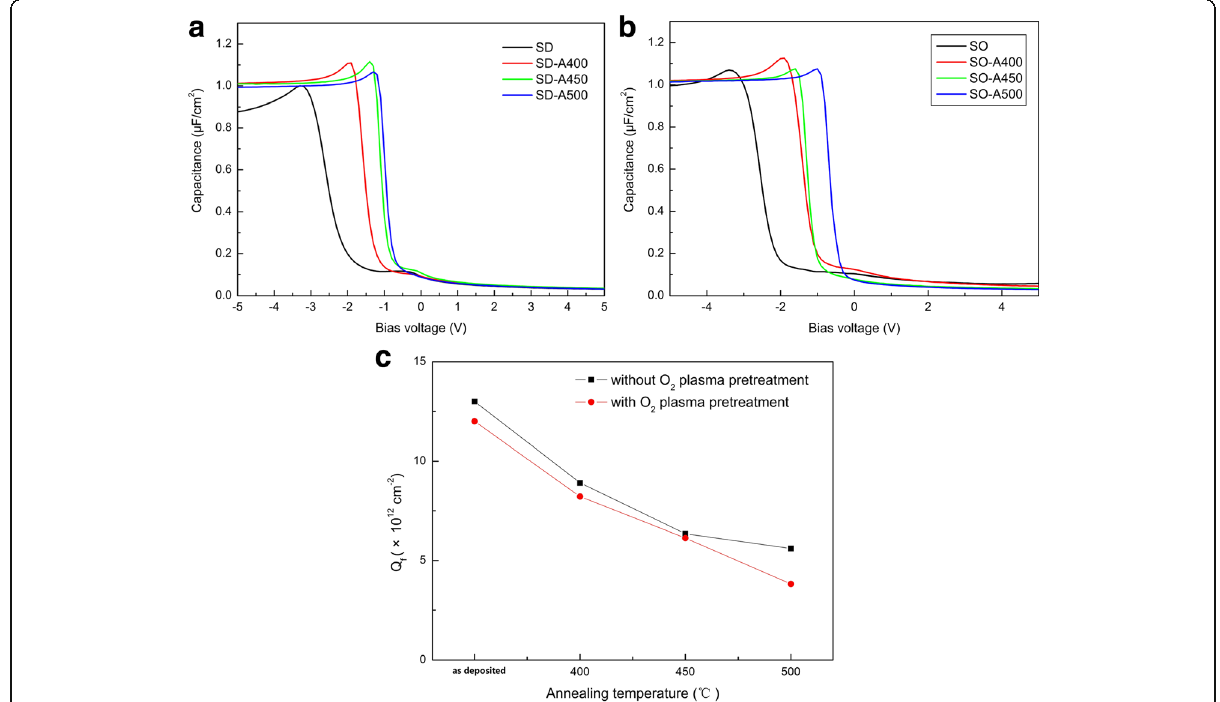
Fig. 2 C-V characteristics measured at 1 MHz for ( a ) directly deposited samples without O 2 plasma pretreatment, and ( b ) samples with O 2 plasma pretreatment; ( c ) estimated Q f of the annealed HfO 2 thin